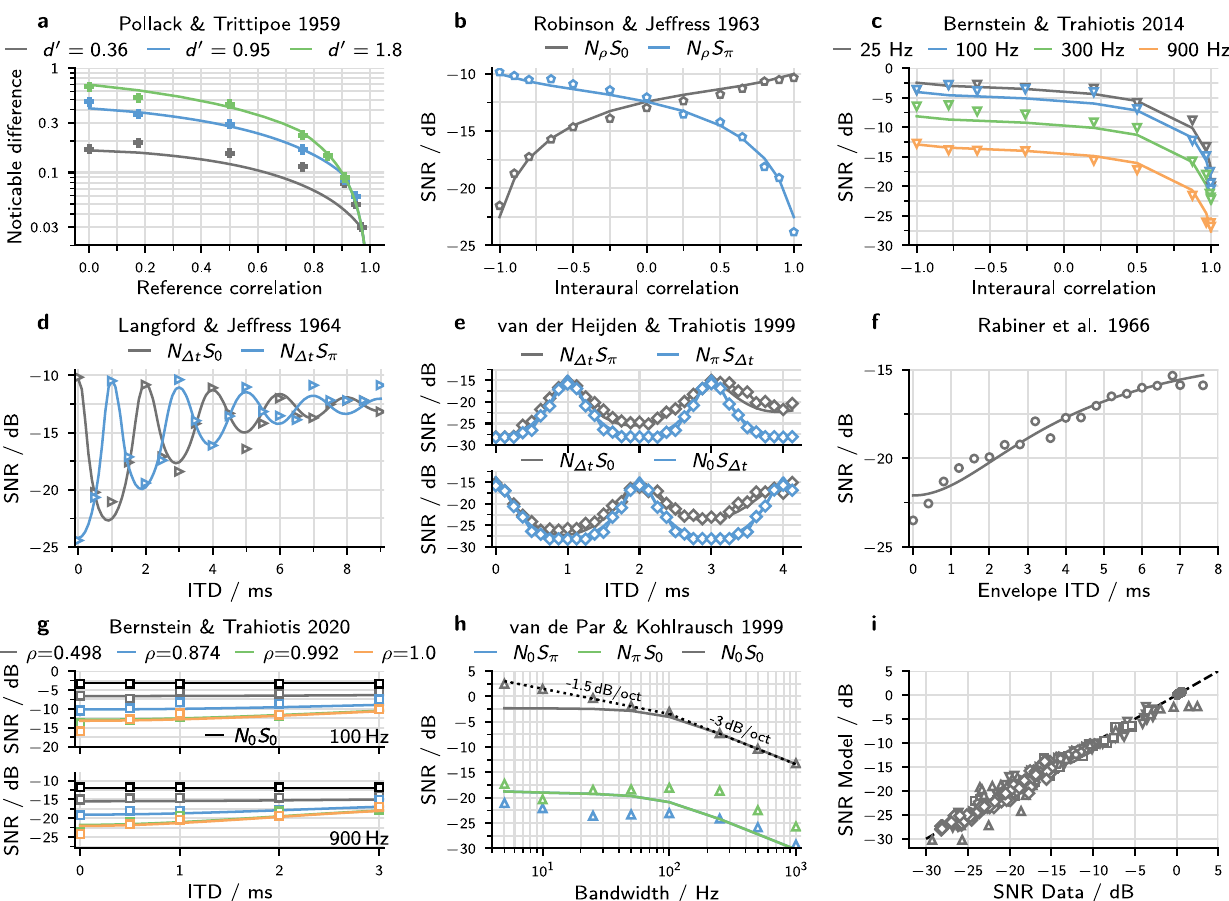
Fig. 2 Experimental data and model results for all experiments. In all cases, symbols indicate the experimental data as digitized from the respective study. Simulated thresholds are shown as lines in matching colors. a Incoherence detection thresholds. The reference noise correlation serves as abscissa and the required change in correlation as ordinate. The different colors indicate different sensitivity indices, i.e., different threshold de fi nitions. b – h Threshold SNRs for seven different studies with the threshold de fi ned as in the respective study. Colors differentiate between conditions. b Dependence on noise correlation. Colors differentiate between the use of in-phase ( N ρ S 0 ) or anti-phasic ( N ρ S π ) tones. c The same experiment as in b for anti-phasic tones only. Colors mark different stimulus bandwidths. d Dependence on noise ITD. Colors indicate the use of an in-phase (gray) or anti-phasic (blue) target tone. e The same experiment as in d with higher ITD resolution (gray data). Additional conditions depict thresholds when the ITD was applied to the tone instead of the noise (blue). f Similar to d but instead of a regular ITD, the ITD is only applied to the envelope of the noise. g Similar to d but the ITD is applied to the whole stimulus (noise and tone). Colors indicate different noise correlations while the N 0 S 0 ) condition is shown in black. Data for a 100 Hz masker bandwidth is shown on the top and 900 Hz on the bottom. Results for the ρ = 0.992 condition are partly concealed by those of the ρ = 1 condition. h Dependence on stimulus bandwidth. Colors mark the interaural con fi guration, including one without binaural cues (gray). Model results for the N 0 S π condition are concealed by those for the N π S 0 ) condition. i Summarizing scatter plot of all 329 simulated threshold SNRs plotted against their experimental counterpart. The dashed diagonal indicates points of equality. Symbols correspond to the respective symbols from b – h